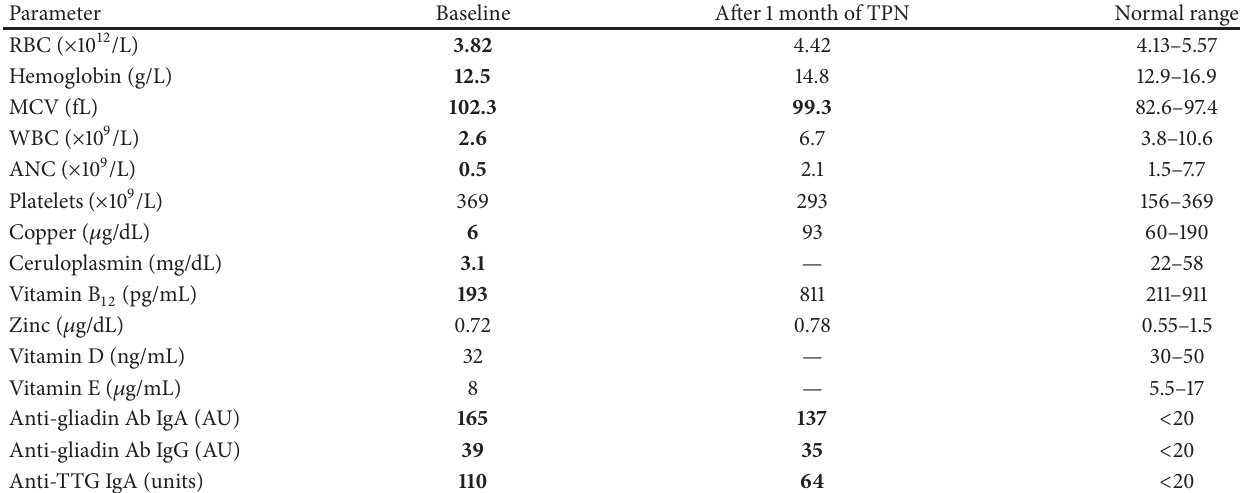
Table 1: Laboratory findings at diagnosis and after 1 month of TPN.